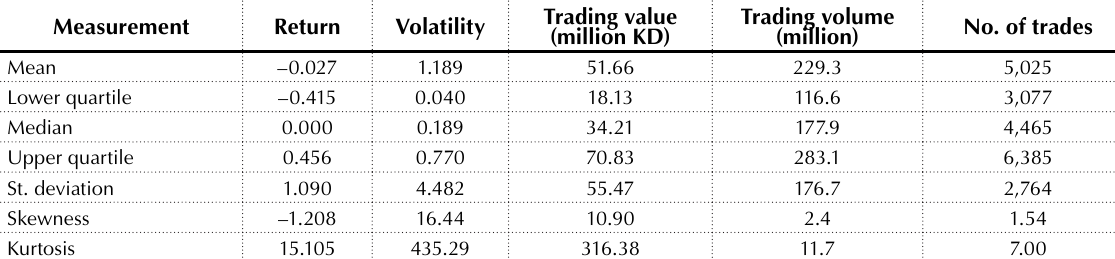
Table 1. Summary statistics of the data